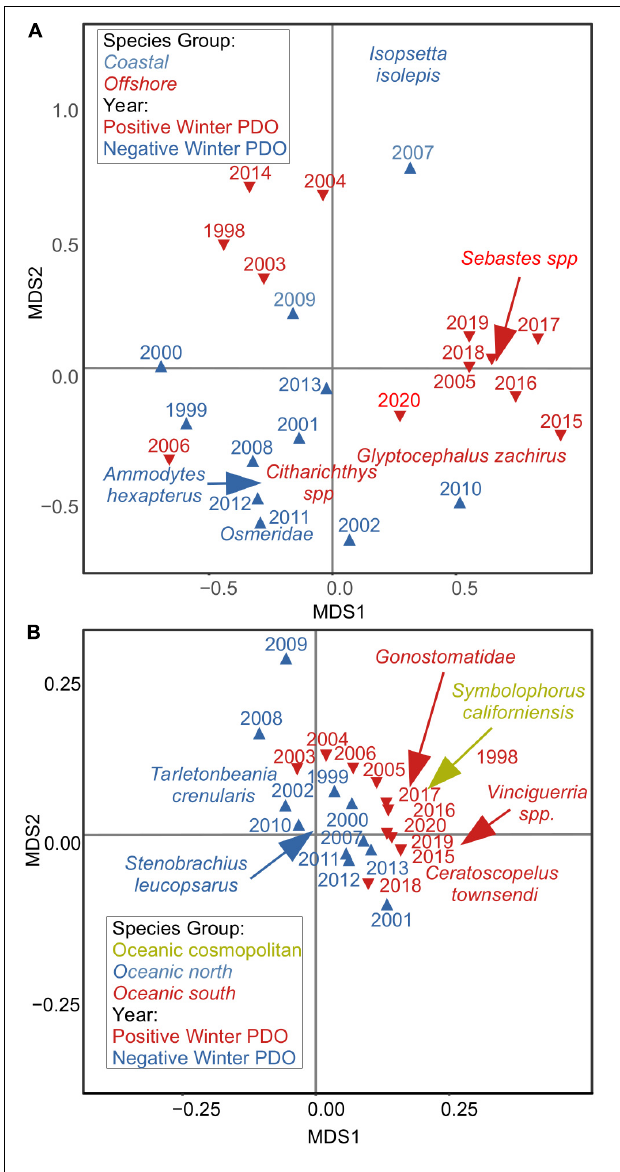
FIGURE 10 | Non-metric multidimensional scaling of ichthyoplankton species by year for winter cruises at the Newport Hydrographic Line (A) and on CalCOFI lines 80 and 90 (B) . Symbol colors indicate positive/negative PDO, and species colors indicate their preferred distributions. Arrows denote actual species positions where they have been moved to improve